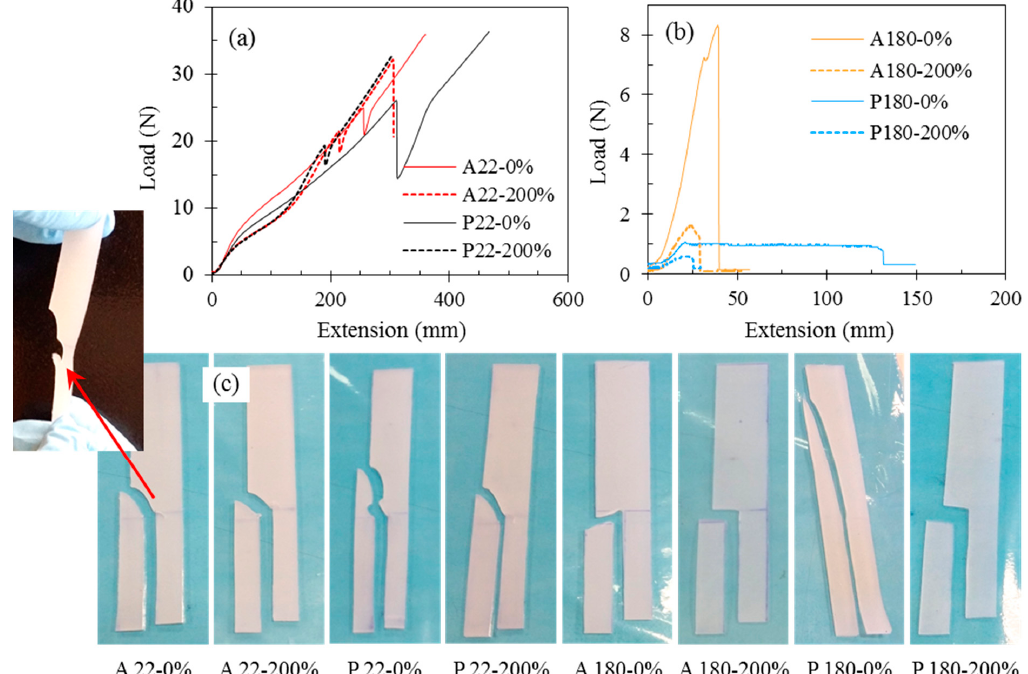
◦ C and ( b ) 180 ◦ C. ( c ) Illustration of